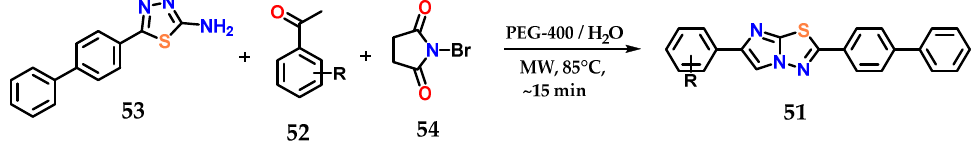
Figure 22. Obtaining benzo[ d ]imidazo[2,1- b ]thiazoles 51 from the condensation of aromatic ketones 52 and 5-(biphenyl-4-yl)-1,3,4-thiadiazol-2-amine 53 .